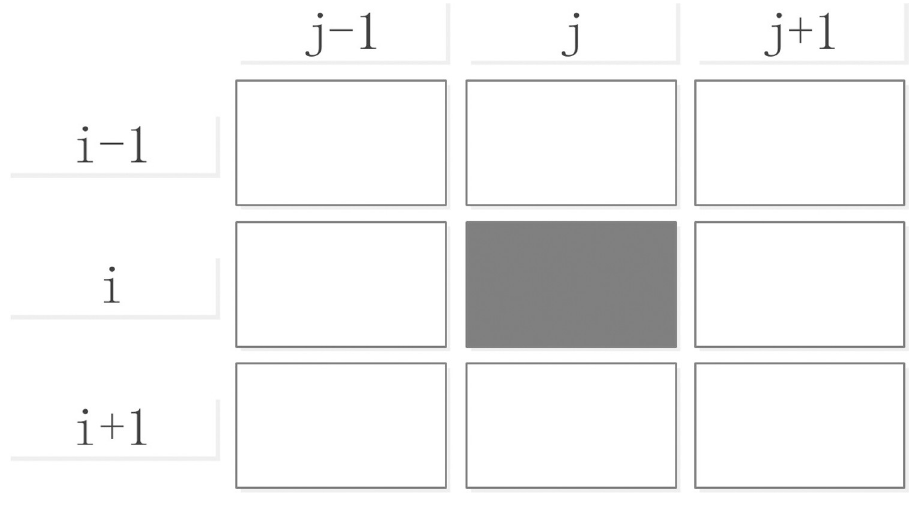
Fig 1. Moore-type neighbor